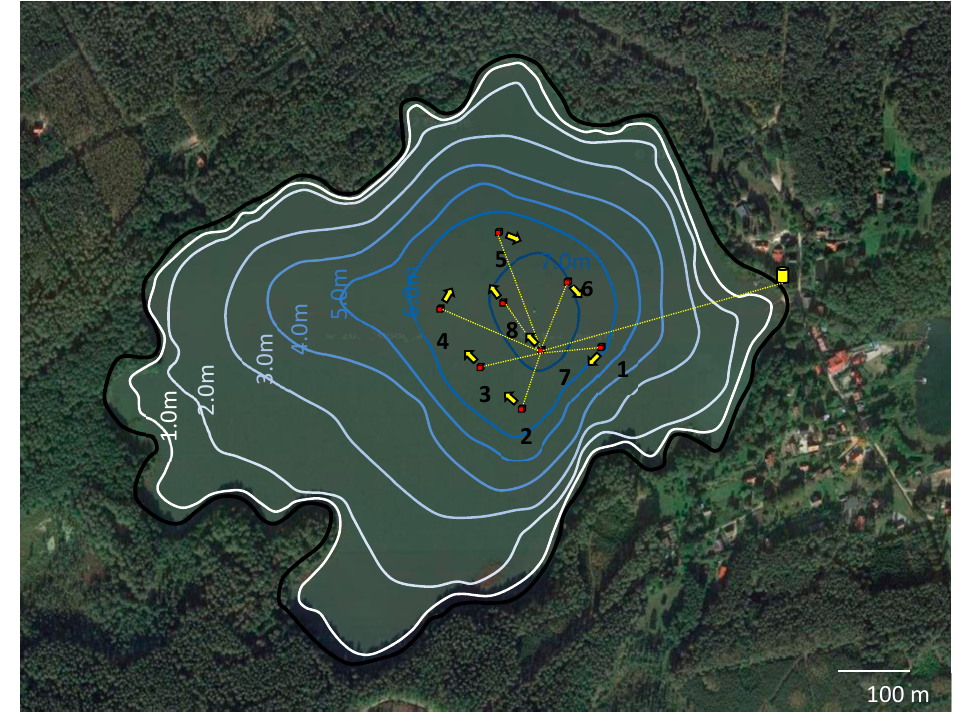
Figure 1. Location of the oxygenation system in Lake Łajskie. Each reactor consists of a column system and a mixing container (Figure 2). Water is taken from the bottom of the lake, and the movement of water inside the reactor’s pipe system is forced by the difference in the density of oxygenated and drawn water. After oxygenation, the water returns to the bottom by one of the reactor pipes and is further distributed through three outlets of an underwater grate with a span of 13 m, suspended 0.5 m above the sediment. The columns and the reactor container are thermally